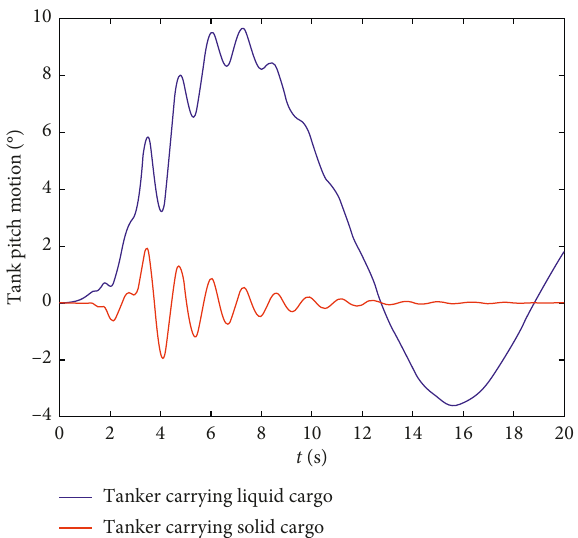
Figure 13: Effect of liquid sloshing on tank pitch motion.